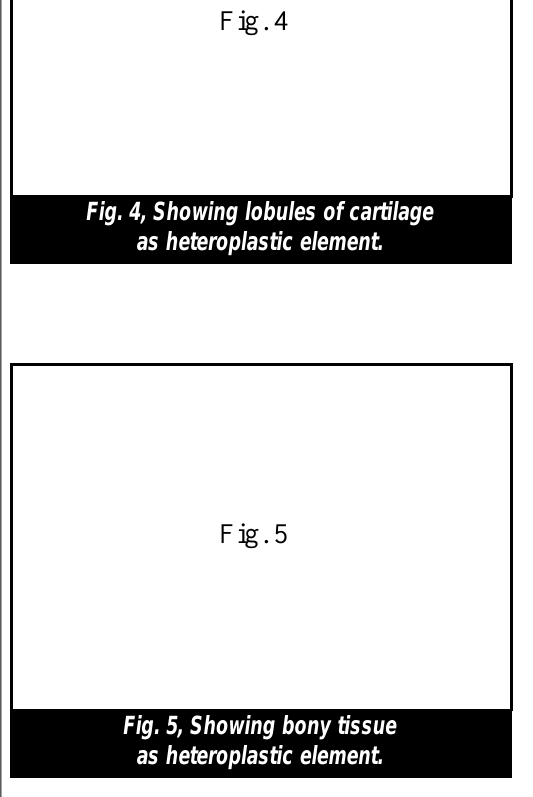
Fig. 3, Showing glial tissue as heteroplastic element.